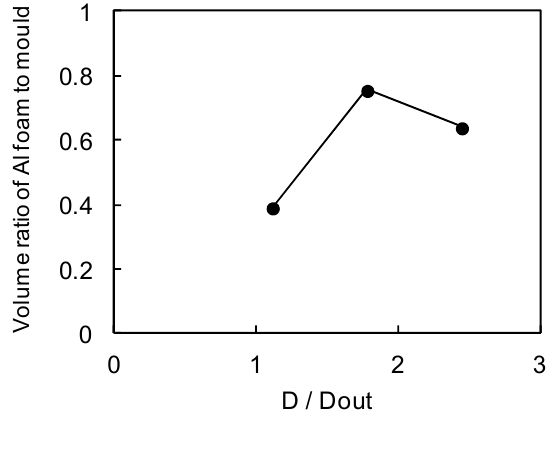
Figure 7. Influence of diameter ratio of mold inlet and die outlet on volume ratio of